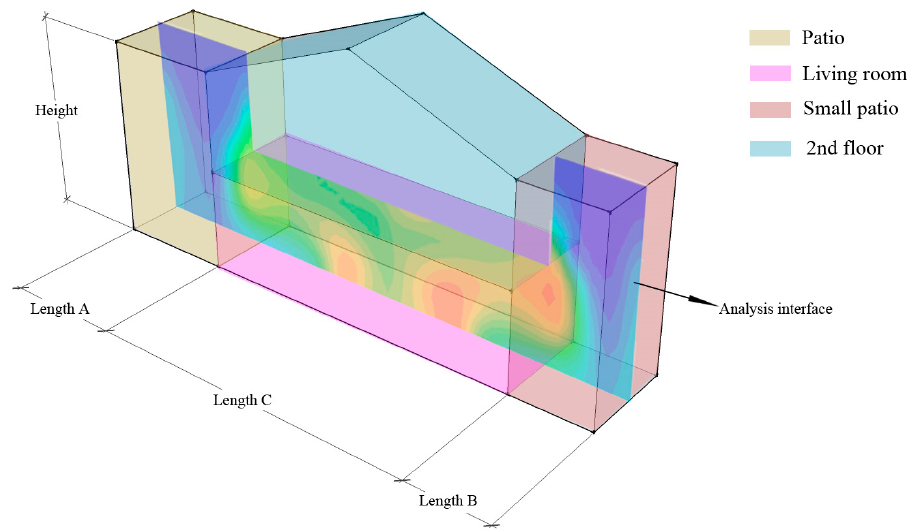
Figure 3. Physical model for stack effect simulation.